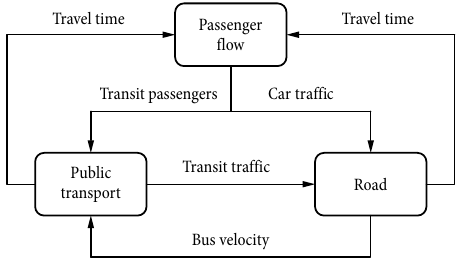
Fig. 1. Urban transport system: passenger flow, public transport and road mutual